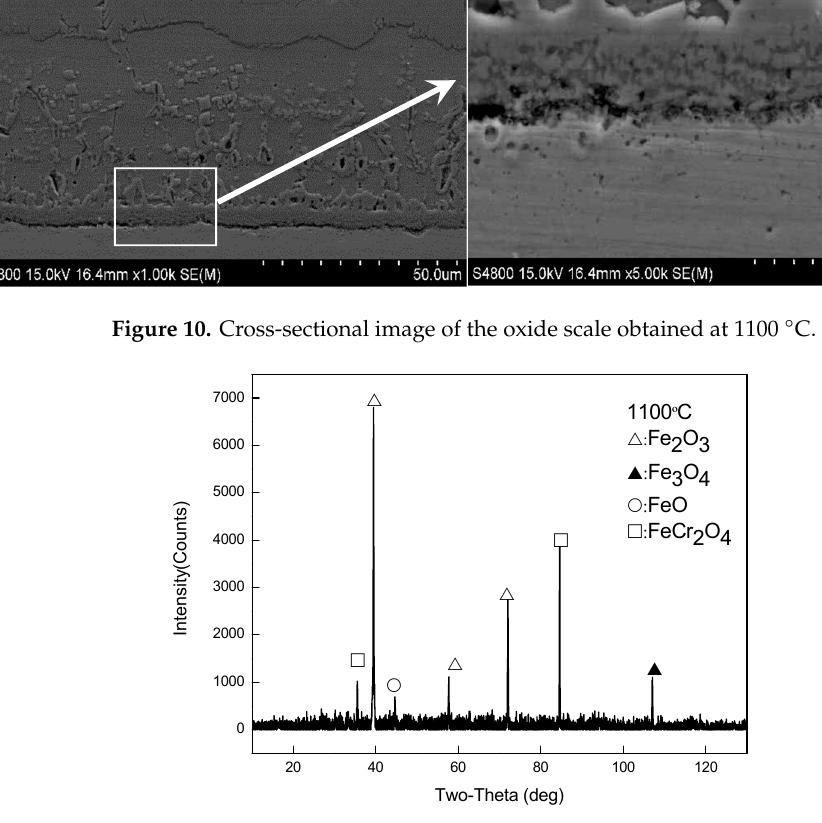
Table 4. EDS elemental maps obtained from the cross-section of the Fe–1Cr–0.2Si steel oxidized at different temperatures.